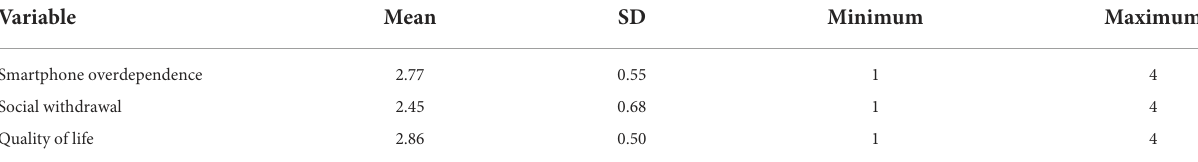
TABLE 3 Correlation. Variable A B C Smartphone overdependence A - Social withdrawal B 0.378***